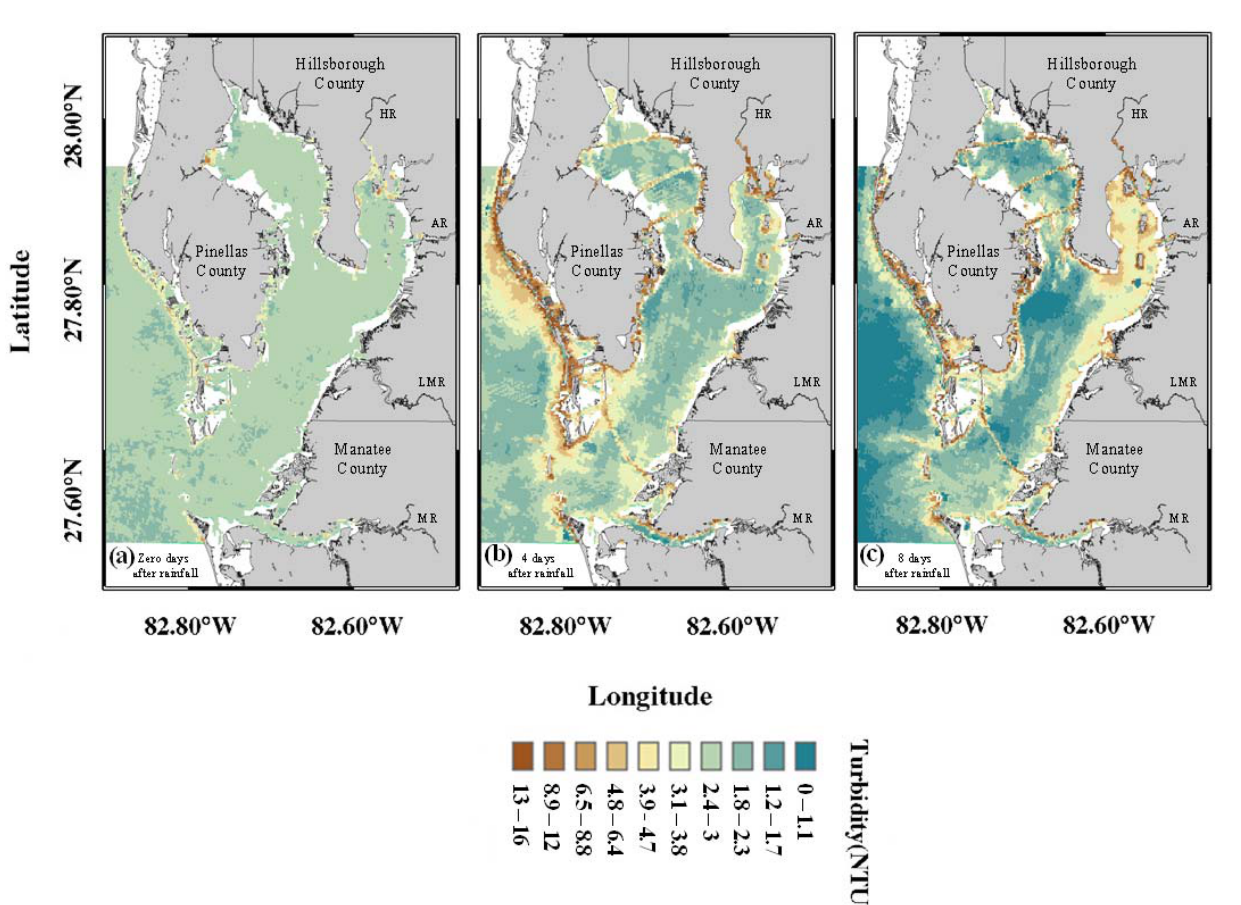
Figure 4. Maps of turbidity derived from MODIS MOD09GQ data. Data for each map correspond to only one image derived within the time interval 2000–2007 and the relationships indicated in Table 2. (a) August 24th, 2004; zero days after rainfall. (b) November 8th, 2004; 4 days after rainfall. (c) November 1st, 2000; 8 days after rainfall. White color within Tampa Bay represents the mask of shallow water (bottom depth < 2.4